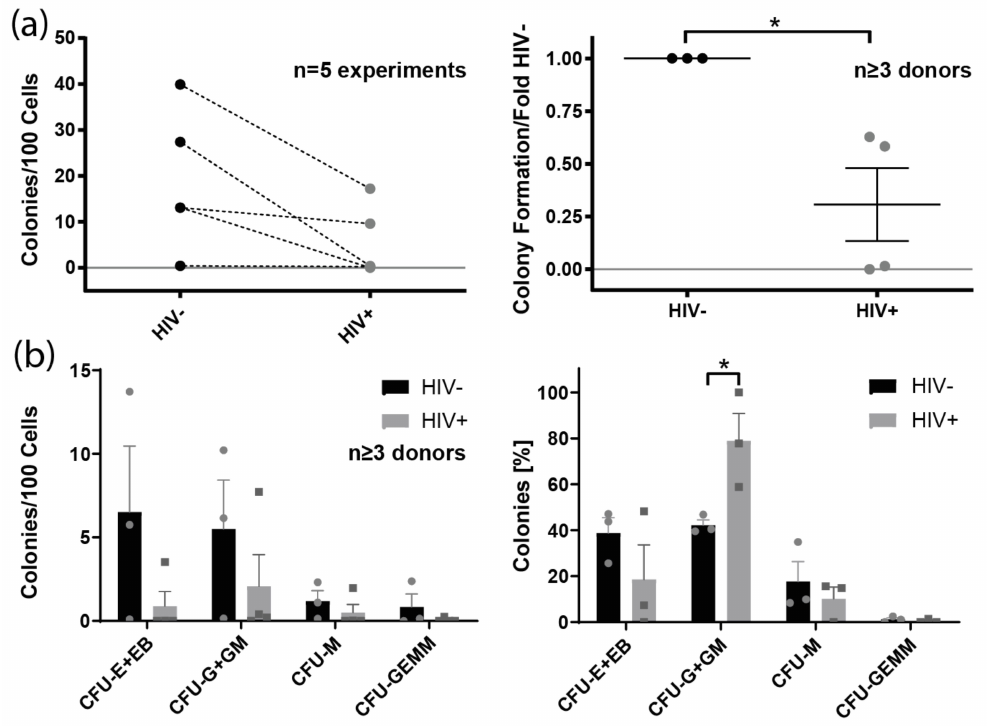
Figure 5. Impairment of colony formation of bone marrow-derived Lin − cells of HIV-1 infected patients. Colony-formation assays of bone marrow-derived Lin − cells from patients infected by HIV-1 and healthy controls. ( a ) Colony formation capacity of Lin − cells from HIV-1 patients compared to uninfected donors showing the numbers of colonies per 100 cells seeded ( left ) and fold change normal- ized to uninfected controls within each assay ( right ); mean and standard error of the mean are shown for five experiments. ( b ) Effects of HIV-1 infection on the absolute colony numbers by subset formed per 100 cells seeded ( left ) and the relative colony numbers by subset ( right ). Mean, standard error of the mean, and individual data points are indicated. Two-tailed t -test comparing HIV − vs. HIV + groups: * p < 0.1. CFU: colony-forming unit; E: erythrocyte colonies; EB: erythroid burst colonies; G: granulocyte colonies; GEMM: mixed granulocyte/erythrocyte/macrophage/megakaryocyte colonies; GM: granulocyte/macrophage colonies; M: macrophage